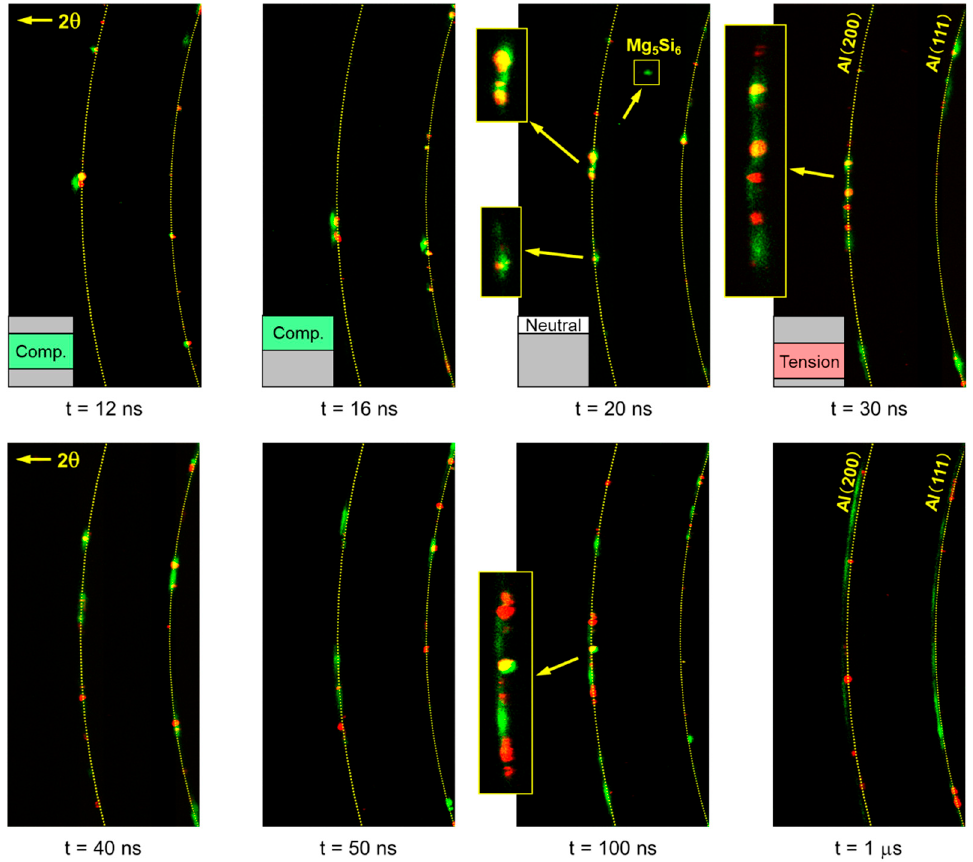
Figure 20. The diffraction patterns of solution heat-treated A6061 aluminum alloy to 1 µs. The insets for 12, 16, 20, and 30 ns schematically show the position of the laser-induced stress wave in the 0.1 mm thick sample. The enlarged images show the changes in the diffraction spots.